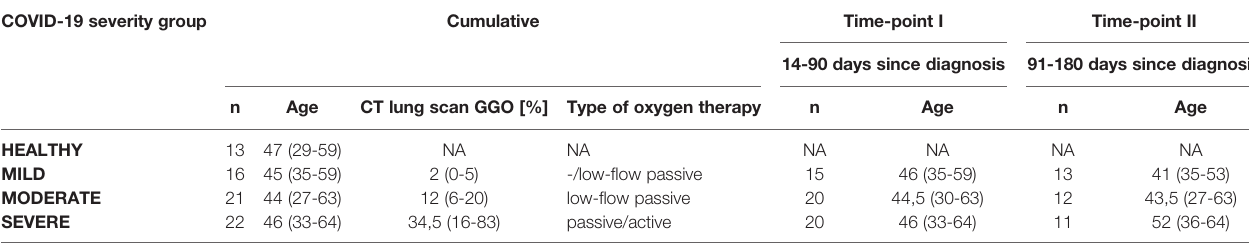
TABLE 1 | Patients strati fi cation into the COVID-19 severity groups: Healthy, Mild, Moderate and Severe. COVID-19 severity group